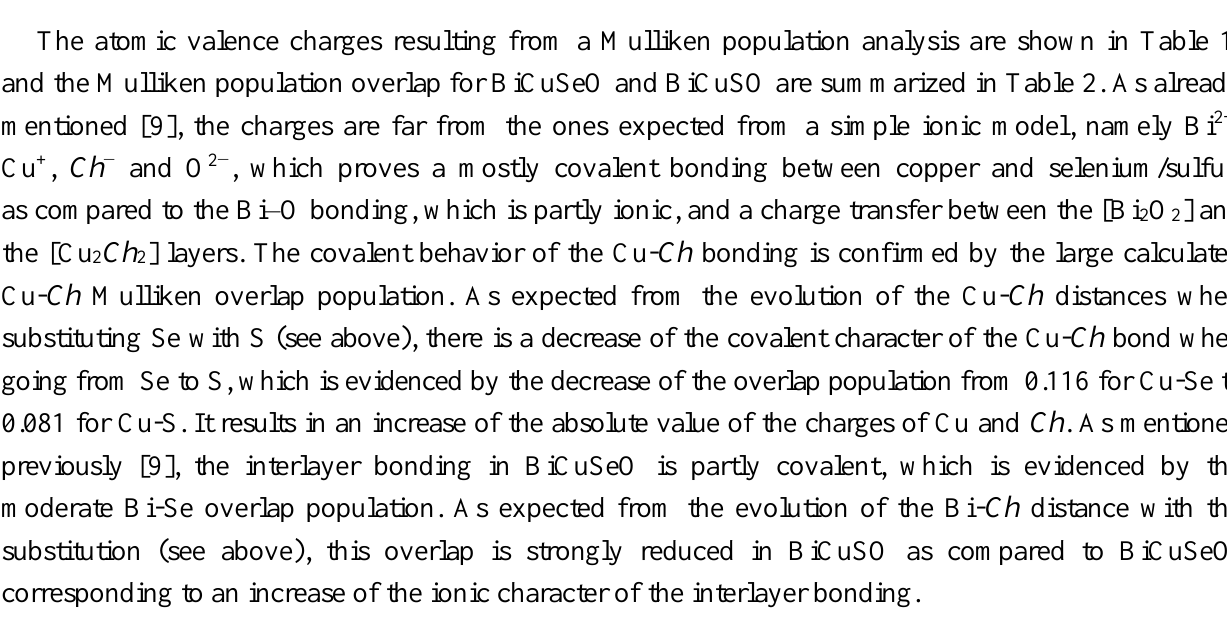
Figure 4. UV-Vis spectroscopy ( a ), for the definition of the y -axis, see text and evolution of the band-gap in the BiCuSe 1−x S x O solid solution ( b ). The spectrum corresponding to BiCuSe 0.2 S 0.8 O was not recorded due to the two large amounts of secondary phases in this compound. The small feature in the spectra around 0.9 eV is due to a small glitch in the baseline, see Figure S2 in the supplementary information.